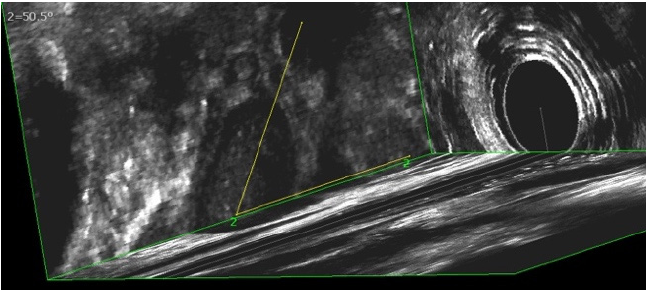
Figure 6. 3D-endoanal ultrasound image: A migrated prosthesis in a 50.5° angle to the anal canal.